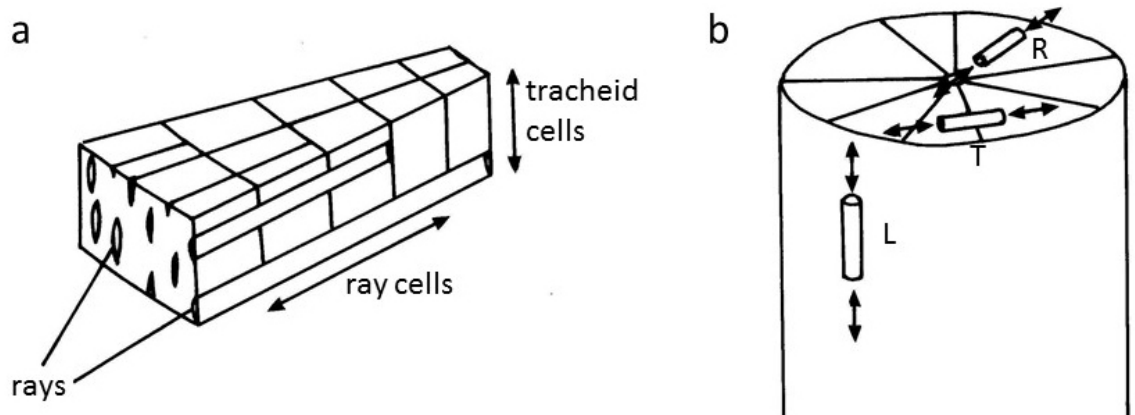
Figure 1. The structure of a branch (Ennos & van Casteren, 2010) (a) most of the wood volume is composed of tightly packed tracheids or fibres, which are oriented longitudinally, while the remainder is made of rays, in which the cells are oriented radially. As a consequence mechanical tests on oriented samples (b) show that tangentially (T) wood is weaker than radially (R) and much weaker than longitudinally (L). Wood is readily split or crushed along the centre-line, along which the rays and tracheids provide no